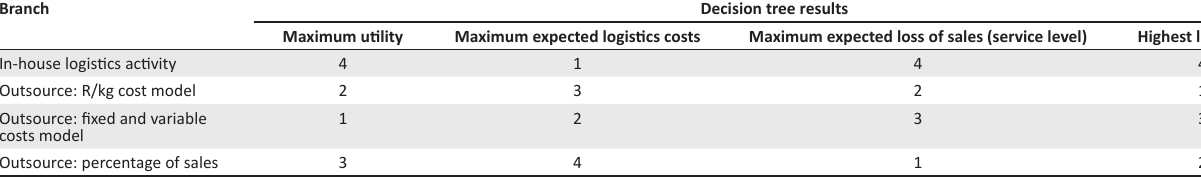
TABLE 6: Comparison of options.